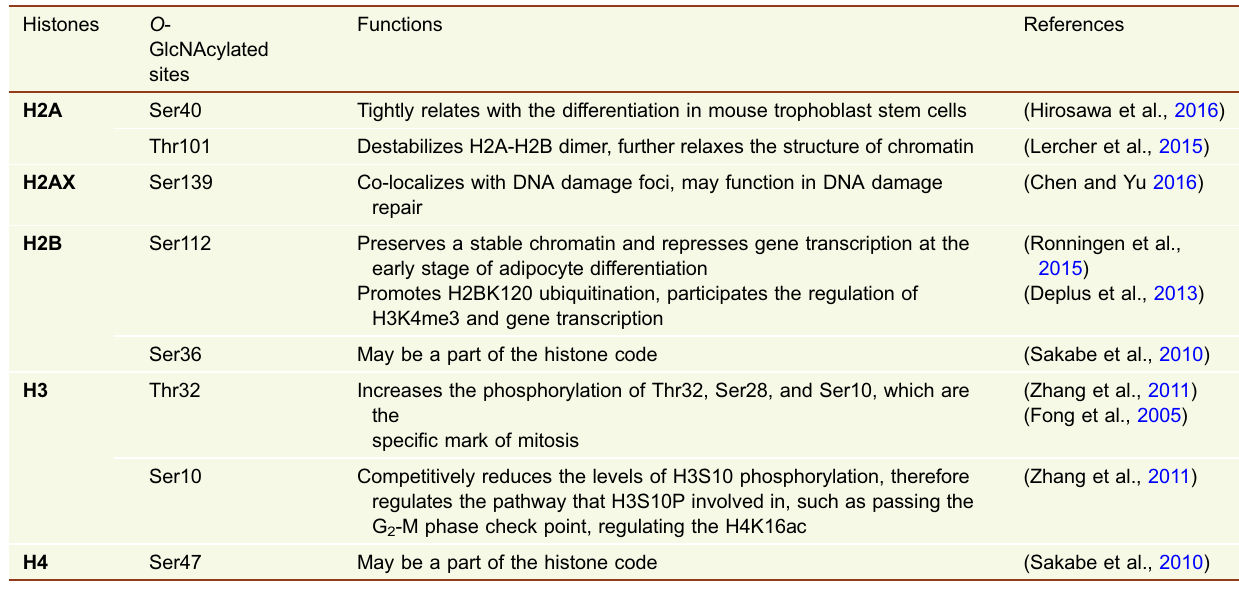
Table 1. O -GlcNAcylation sites and functions of histone tails. O -GlcNAc modi fi cation is observed in all four histones (H2A, H2B, H3 and H4) as well as histone variants H3.3 at indicated